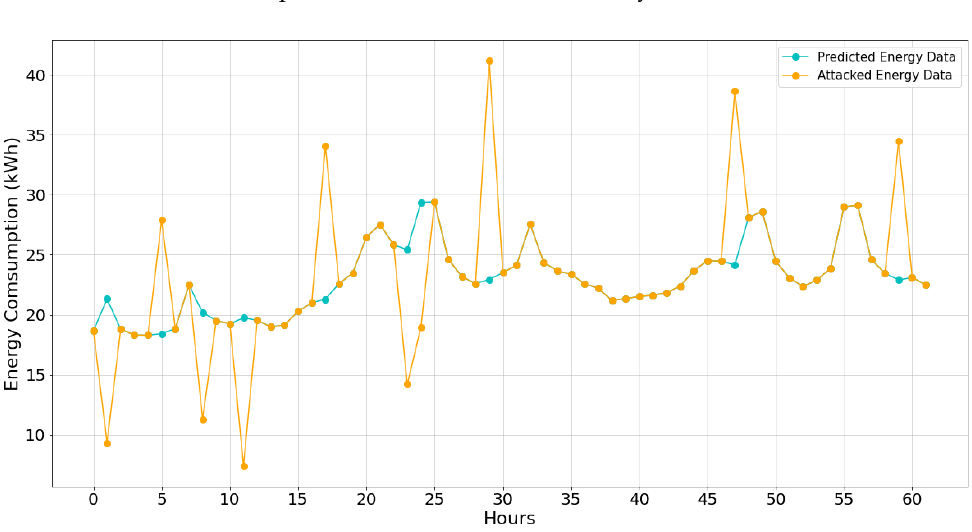
Figure 5. Attack detection in the proposed AI-ADP